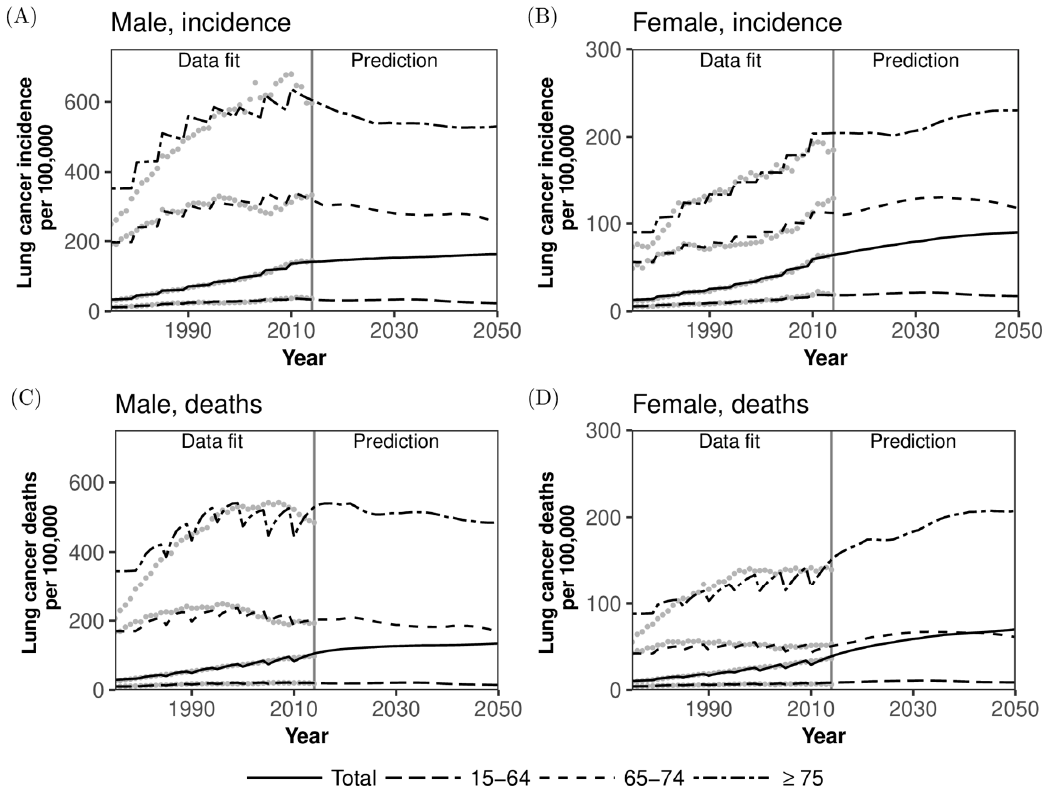
Figure 3. Comparison between observed and predicted lung cancer incidence and mortality per 100,000 population in Japan. Comparisons between observed and predicted lung cancer incidence and mortality per 100,000 population are made by age group and sex. ( A ) Lung cancer incidence in men, ( B ) Lung cancer incidence in women, ( C ) Mortality in men, and ( D ) Mortality in women. Bold dashed line represents working-age population aged 15–64 years, thin dashed line corresponds to those aged 65–74 years, uneven dashed line represents those aged 75 years or older, and solid line represents the entire population. Grey dots before 2014 were used to estimate model fitting parameters via the maximum likelihood method, and lines for 2015 and later are predictions calculated using maximum likelihood estimates at the latest time. The 95% confidence intervals are omitted from predictions because of the narrow uncertainty